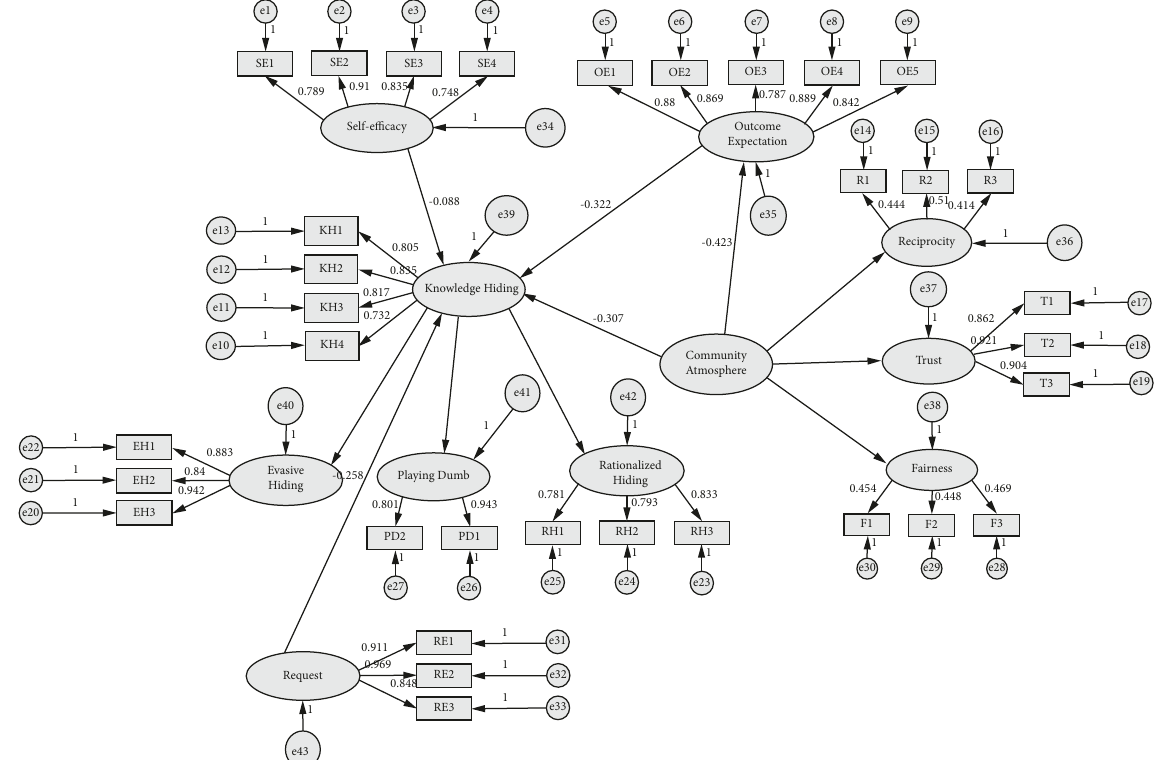
Figure 3: structural equation model normalized path